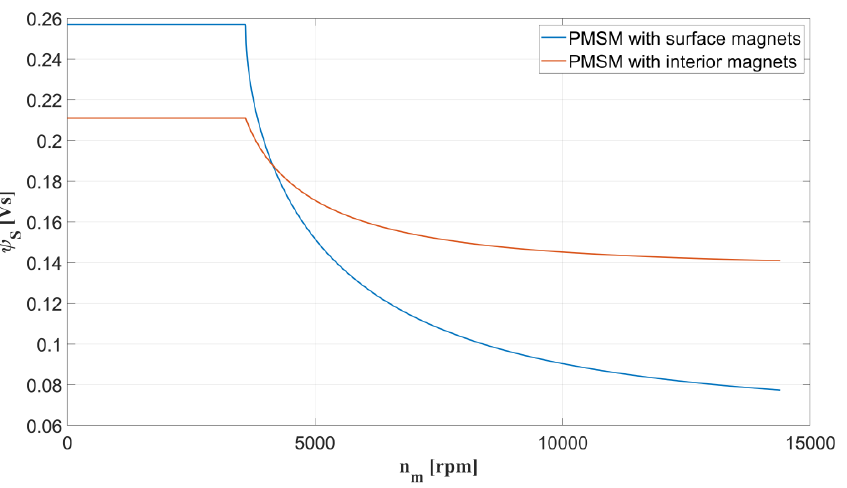
Figure 3. Ideal characteristics for the two-region control of an IPMSM (𝑖 𝑆𝑑 ≠ 0) .